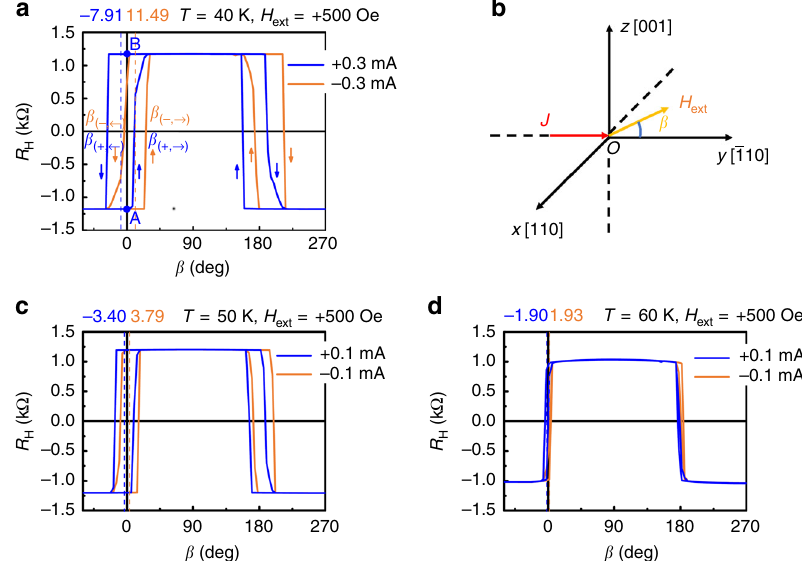
Fig. 4 Spin – orbit torque strength in the Ga 0.94 Mn 0.06 As thin fi lm. a R H measured with a current of ±0.3 mA and an external fi eld of 500 Oe applied at an angle β from the (cid:1) 1 10 ½ (cid:2) direction in the y-z plane. The arrows in the graph represent the sweeping directions of β . b Illustrations of the current ( J ), the external magnetic fi eld ( H ext ) and β . c , d R H measured with the current of ±0.1 mA and an external fi eld of 500 Oe applied at an angle β from the (cid:1) 1 10 ½ (cid:2) direction in the y-z plane at T = 50 K ( c ) and T = 60 K ( d ). (Source data are provided as a Source Data fi le) ½ (cid:1) 110 (cid:2) direction in the y-z plane as shown in Fig. 4a, b. When the current is positive (see the blue lines in Fig. 4a), ^ τ is along the – ST x direction, which gives a force to the magnetization in the counterclockwise direction when we see it from the + x direction